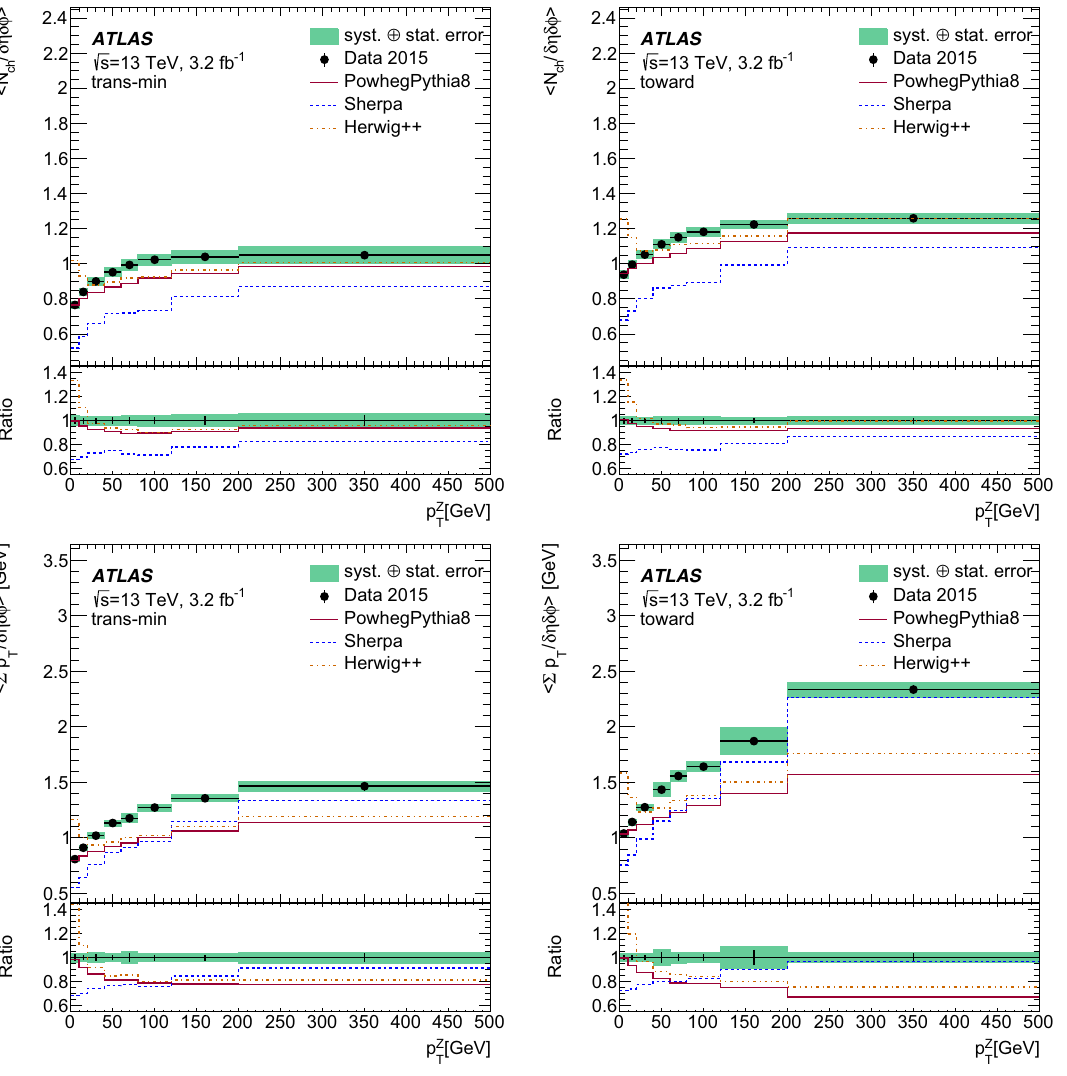
Powheg + Pythia , Sherpa and Herwig++ are compared with the for the trans-min T